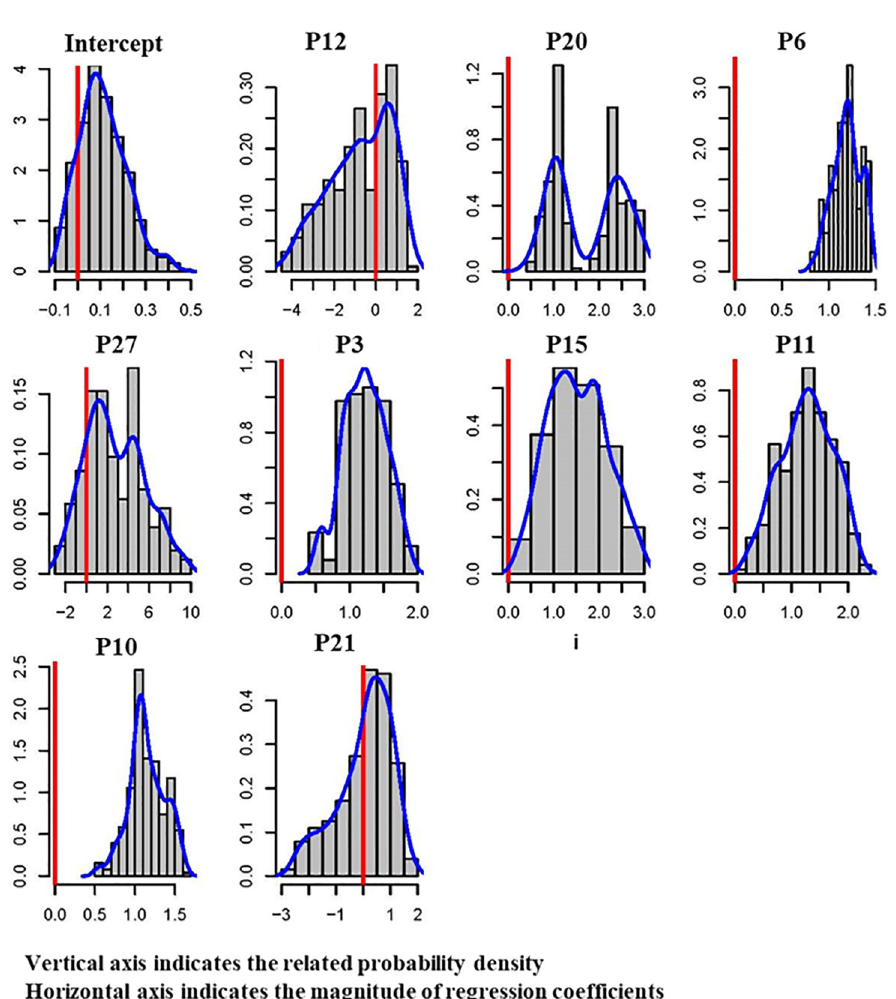
Fig 7. Schematic results of EBA for reconstruction schedule performance